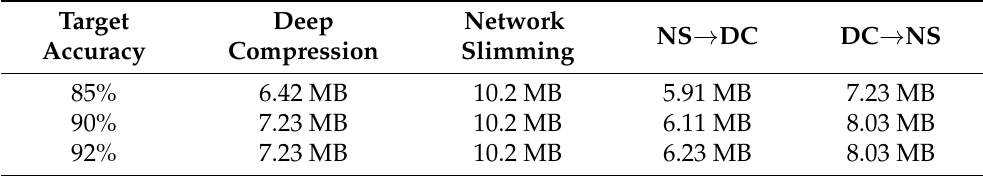
DC and DC NS for VGG-19. → →